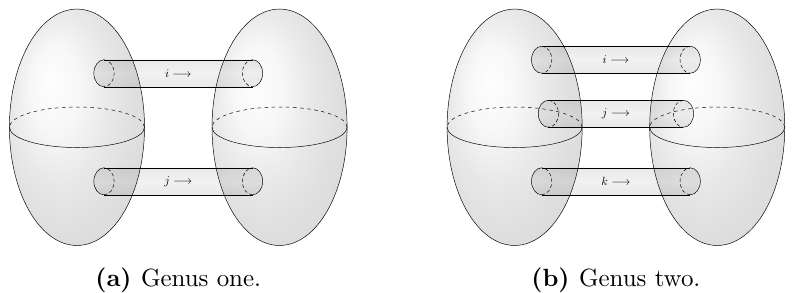
Figure 1. Surfaces constructed by gluing together two spheres with cylinders. The partition function is then a sum over states labelled i; j; k propagating along the cylinders, times the square of a two- or three-point function on the